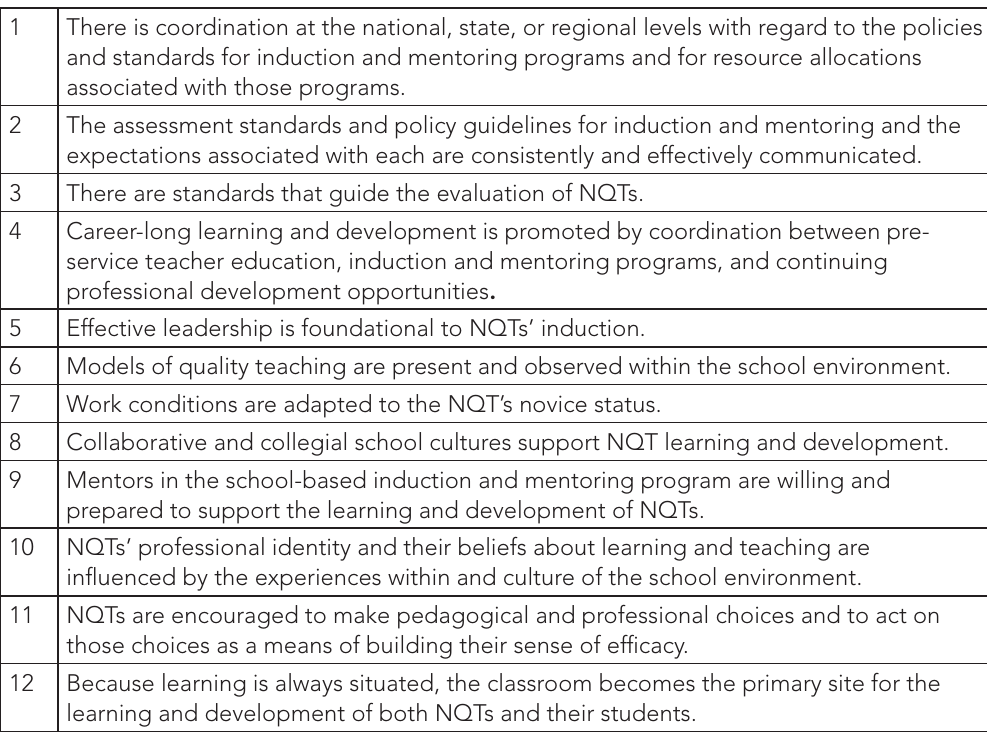
Table 1. Twelve principles for induction and